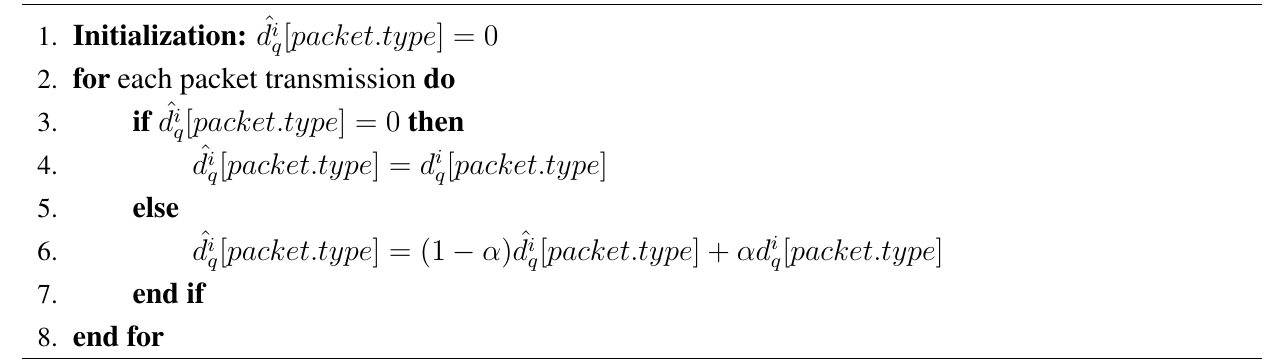
Algorithm 3 Queuing Delay Estimator, at each node i